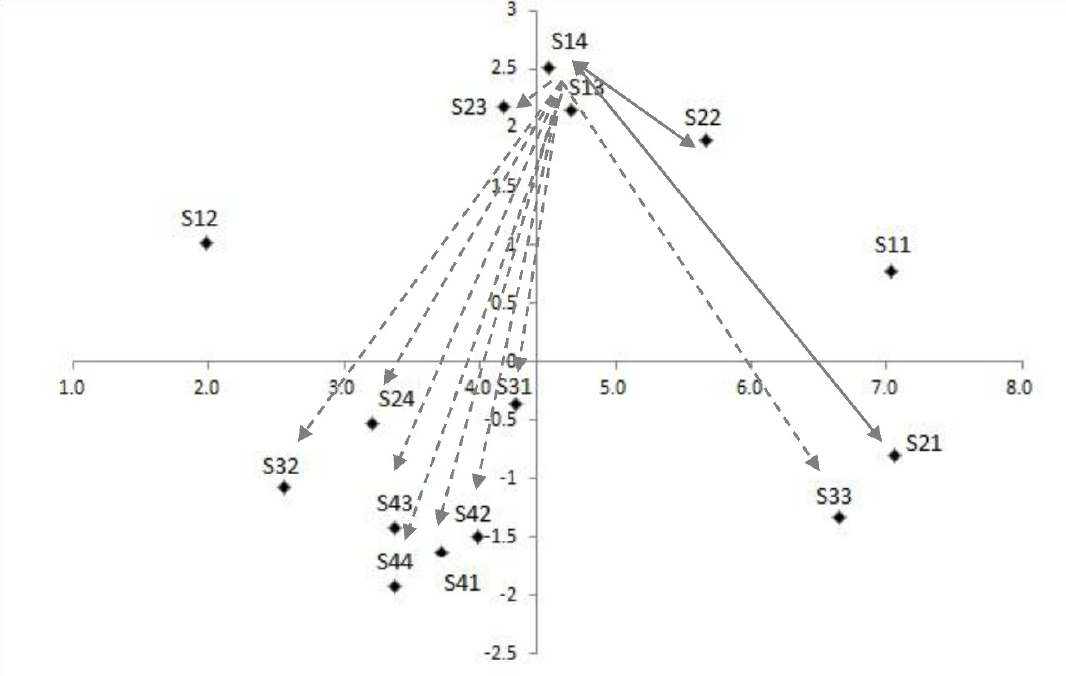
Figure A4. Casual Diagram between S14 and Other